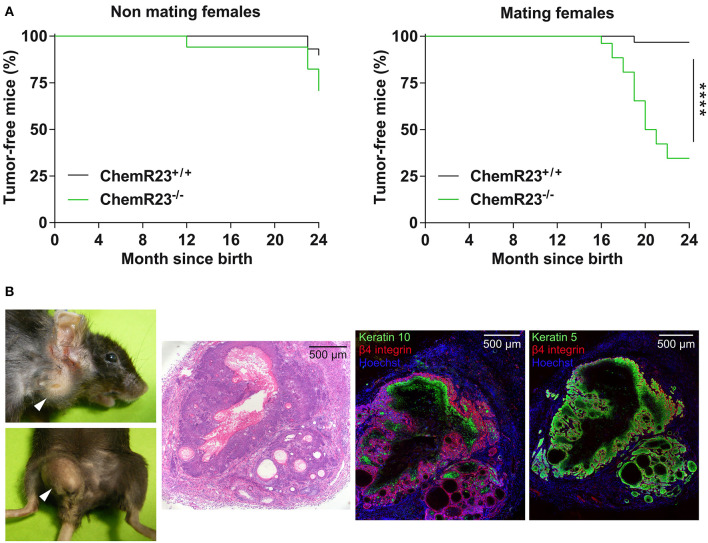
Mice invalidated for ChemR23 develop spontaneous skin tumors. (A) Kaplan-Meyer plots representing the percentage of tumor-free mice in cohorts of control and ChemR23−/− female mice kept chronically (right panel, n = 30 and 25 for respectively, controls and ChemR23−/−) or not (left panel, n = 26 and 17 for respectively controls and ChemR23−/−) in conditions of mating. The data are analyzed by Log-rank test. ****P < 0.0001. (B) Spontaneous skin tumors located in the neck and perineal regions of aged ChemR23−/− female mice (left panels). White arrowheads indicate the location of tumors. Hematoxylin-eosin staining and immunostaining of keratin 10, keratin 5, and β4 integrin in a spontaneous skin tumor (right panels).